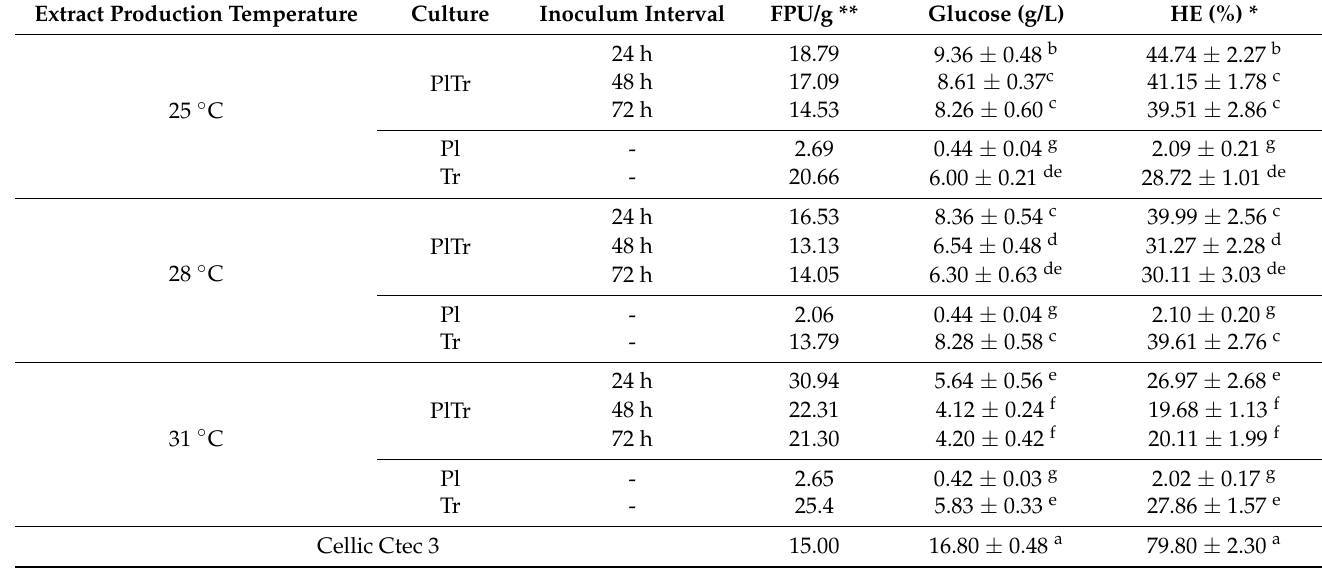
Table 2. Glucose released and sugarcane bagasse hydrolysis efficiency of crude enzyme extracts of monocultures and co-cultures of P. lecomtei (Pl) and T. reesei (Tr). The fungi were cultured in submerged fermentation using the Initial medium (IM), which contains oil palm decanter cake (OPDC). Enzymatic hydrolysis of sugarcane bagasse was carried out using 5% ( w / v ) of solids, during 48 h, 200 rpm at 50 ◦ C. Different letters in the same collumn mean significant differences ( p < 0.05) according to the Tukey